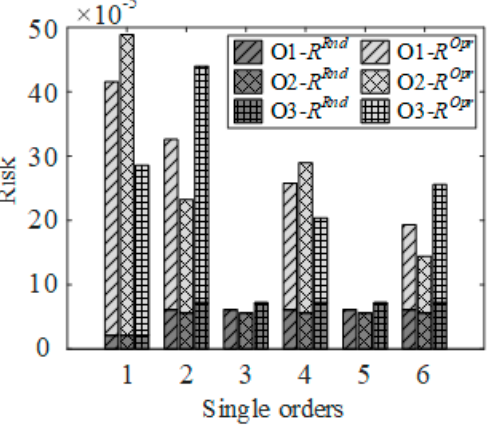
Figure 10. Comparison of risk results of different dispatching orders. Figure 3. The dependent components of cyber system functions at switchgear components (SCs) in the same substation.